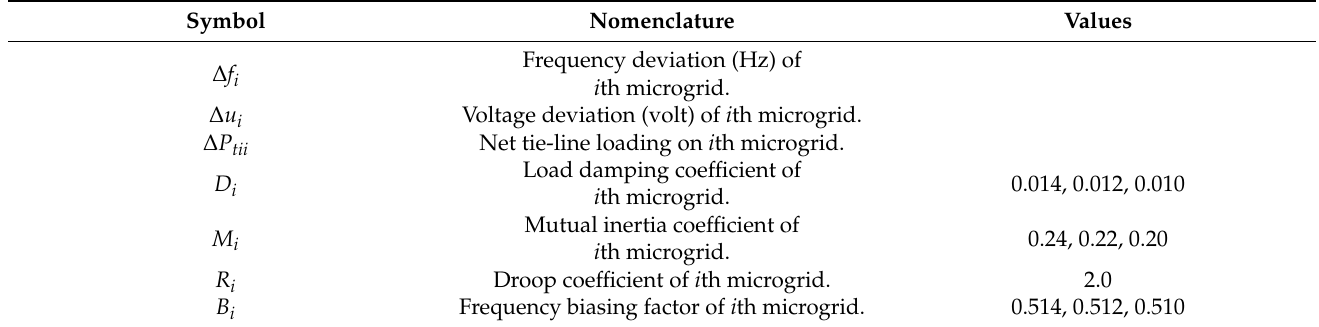
Table 1. Nomenclature used in this